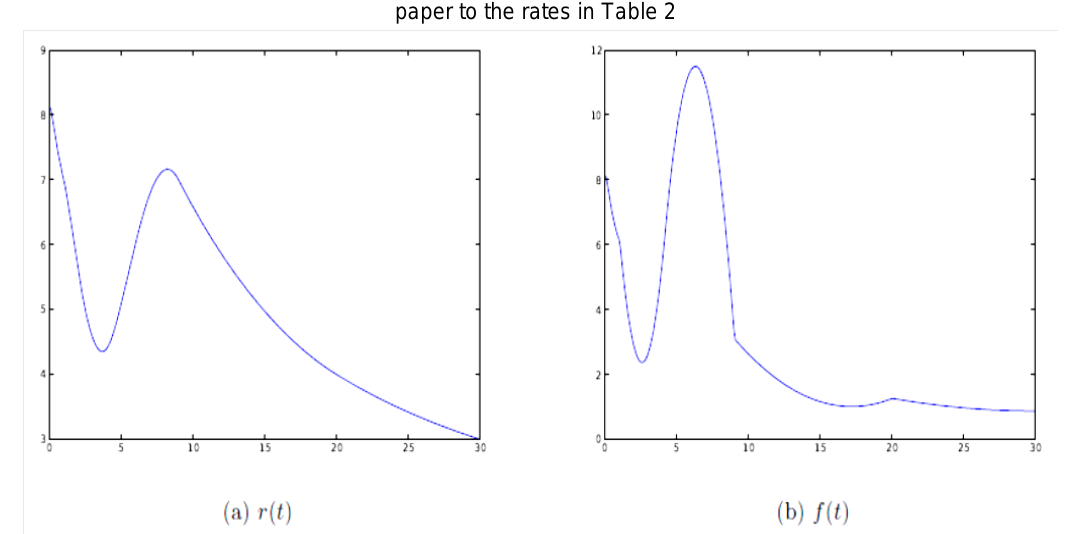
Spot and forward curves obtained by applying the method presented in this paper to the rates in Table